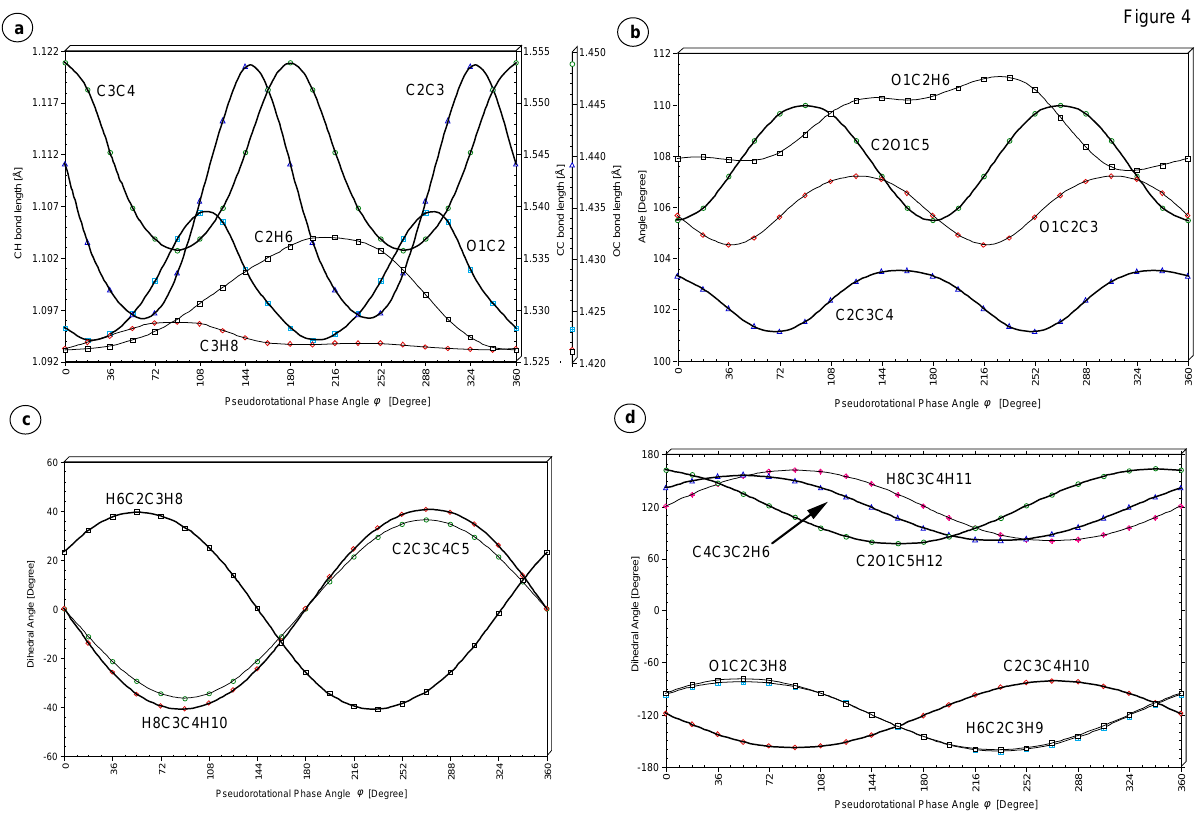
Figure 4: Dependence of the internal coordinates of THF on the pseudorotational phase an- gle φ . (a) Bond lengths R(O1C2), R(C2C3), R(C3C4), R(C2H6) and R(C3H8). (b) Bond an- gles α (O1C2C3), α (C2C3C4), α (C2O1C5) and α (O1C2H6). (c) Dihedral angles τ (C2C3C4C5), τ (H8C3C4H10) and τ (H6C2C3H8). (d) Dihedral angles τ (O1C2C3H8), τ (C2O1C5H12), τ (C2C3C4H10), τ (C4C3C2H6), τ (H6C2C3H9), and τ (H8C3C4H11). For the numbering of